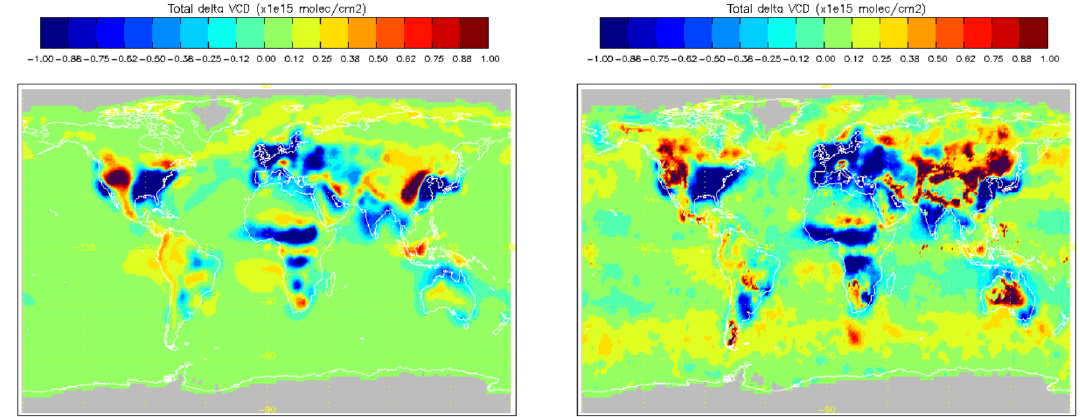
Figure 13. Total tropospheric NO 2 columns differences between cloudy (CRF > 50%) and clear (CRF < 25%) conditions for TM4 (left) and OMI (right).